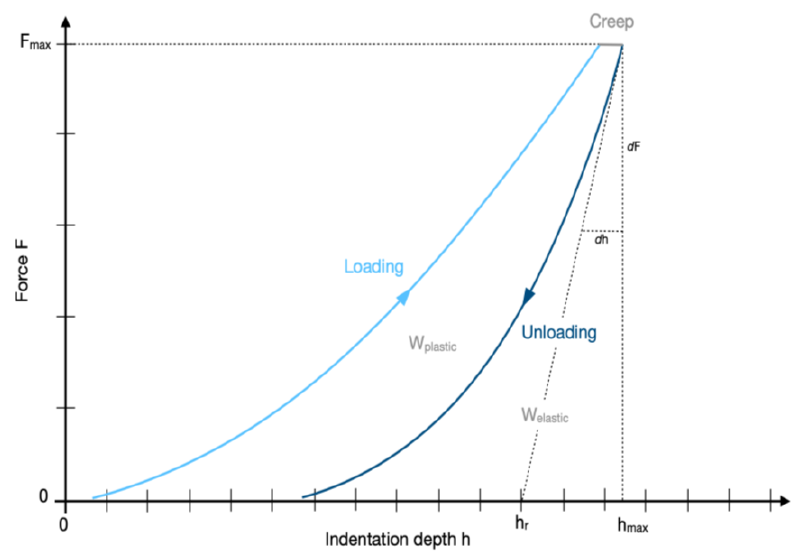
Figure 4. Showcase force–indentation depth curve. W plastic/elastic = plastic/elastic indentation work; dF/dh = contact stiffness S; F max = maximum force; h max = maximum indentation depth; h r = depth at contact stiffness tangent.